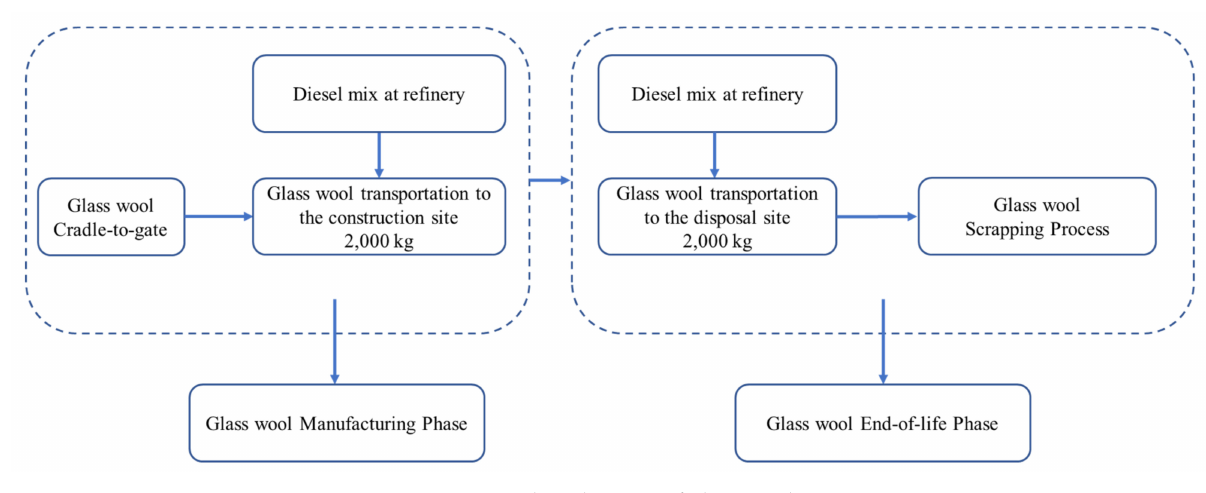
Figure 7. Flow diagram of glass wool.